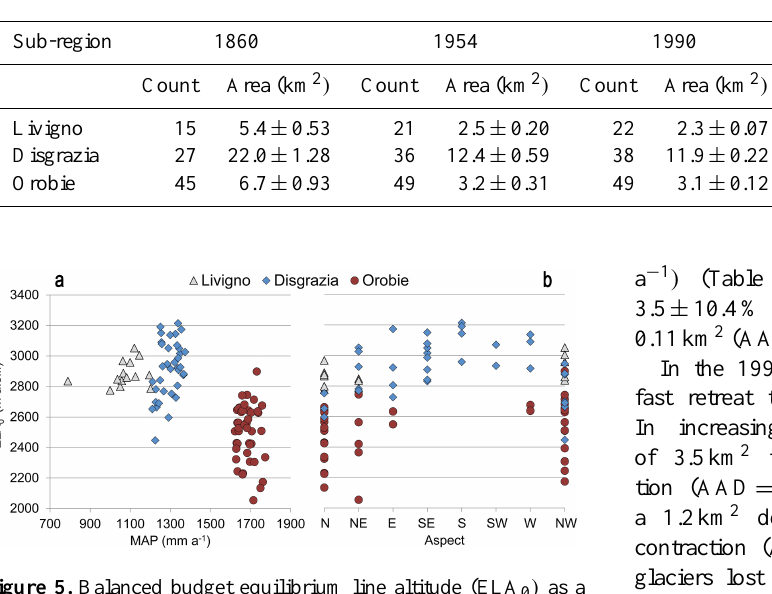
Figure 4. Latitudinal transect across the Livigno, Disgrazia, and Orobie sub-regions. Dashed lines indicate minimum and maximum elevation, and solid lines indicate mean elevation. Filled symbols and crosses refer, respectively, to the ELA 0 (stratified by dominant slope aspect) and mean annual precipitation (MAP) values associated with each study glacier. Table 3. Variation of glacier count and glacierized area through time in the study sub-regions.